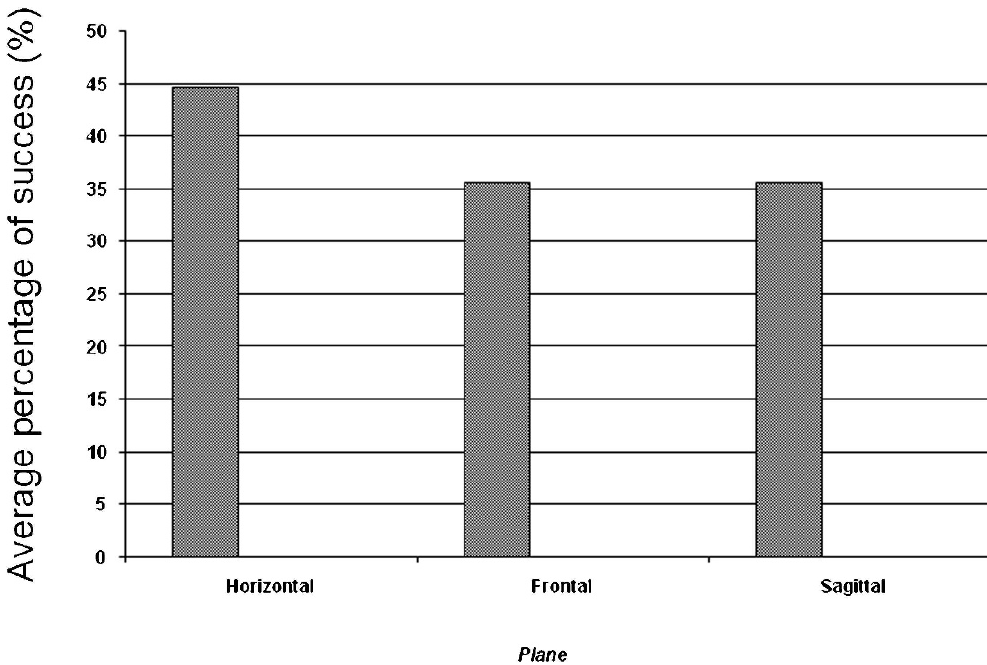
Figure 1 - A comparison of the average percentage of correct sound localization responses for each